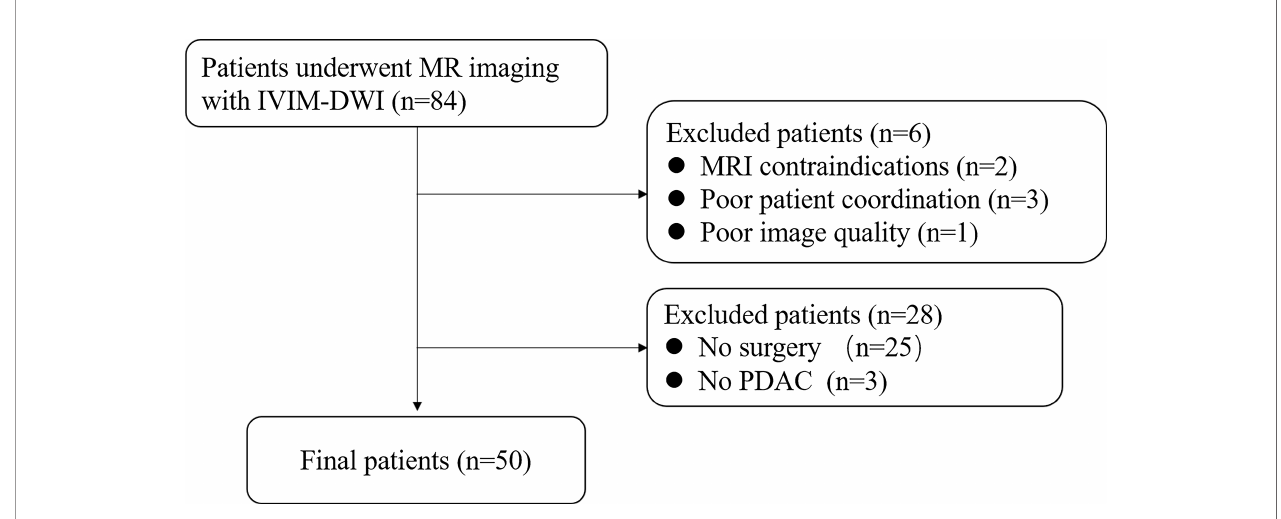
FIGURE 1 | Schematic of the patient selection